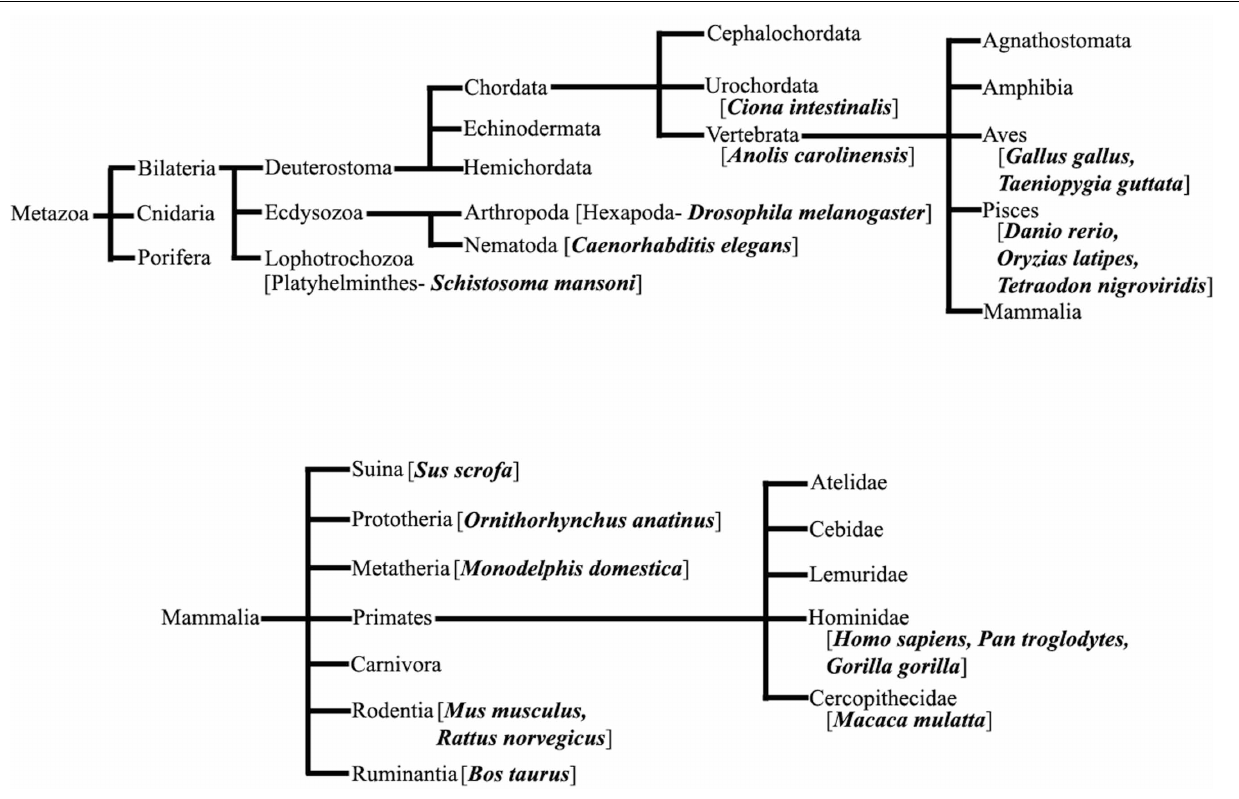
FIGURE 1 | Species under Metazoa. The detail classification of 20 species (bold) which are chosen in this